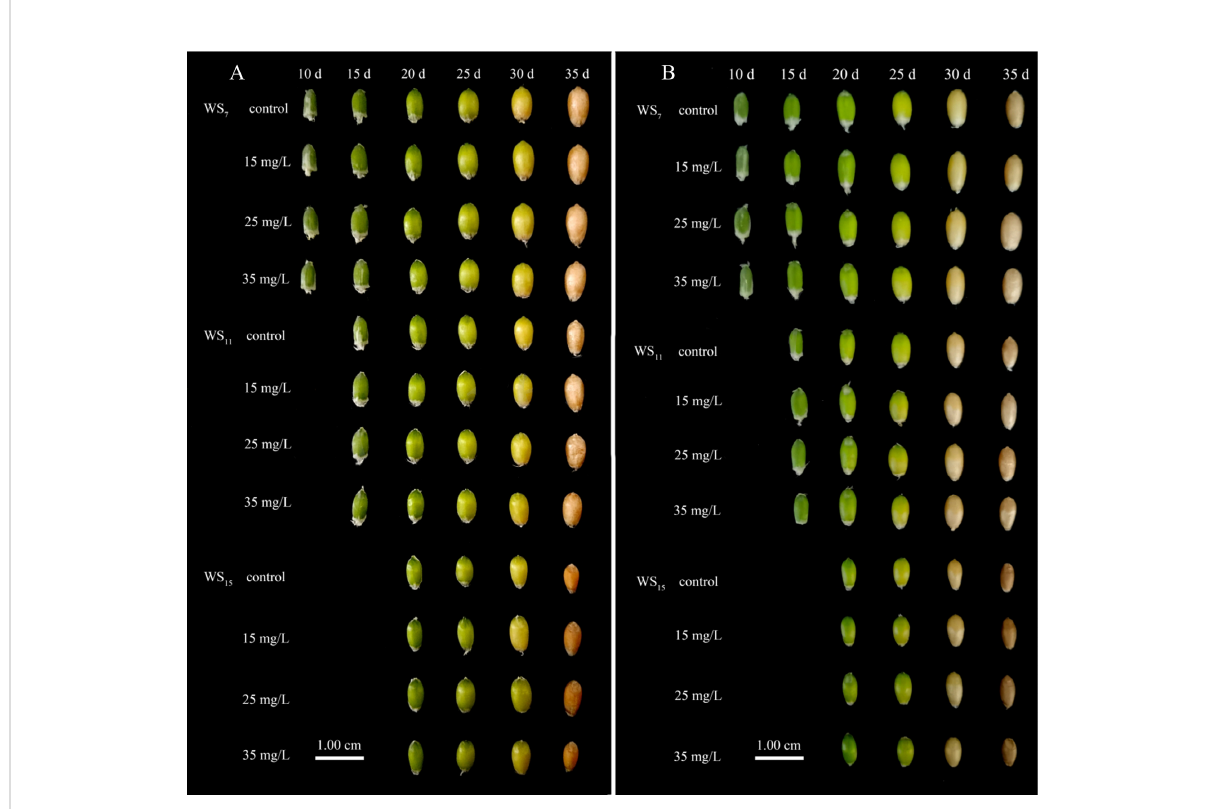
FIGURE 3 The effect of exogenous 6-BA on grain morphology of wheat under waterlogging and shading. The waterlogging-tolerant (Yangmai 18, 2021 A ) and the waterlogging-sensitive (Sumai 188, 2021 B ) were waterlogging and shading during anthesis. WS 7 , WS 11 , and WS 15 respectively represent treatments under waterlogging and shading for 7, 11, and 15 days after anthesis. Shade nets with a shading rate of about 45% were used for shading, and waterlogging preserves about 2 cm of moisture on the surface of the soil. Control is the treatment of spraying the same amount of